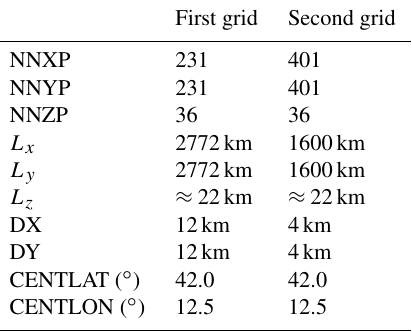
Table 1. RAMS grid setting for the first and second grids. NNXP, NNYP, and NNZP are the number of grid points in the west–east, north–south, and vertical directions. L x (km), L y (km), L z (m) are the domain extensions in the west–east, north–south, and vertical directions. DX (km) and DY (km) are the horizontal grid resolu- tions in the west–east and north–south directions. CENTLON and CENTLAT are the geographical coordinates of the grid centres. First grid Second grid